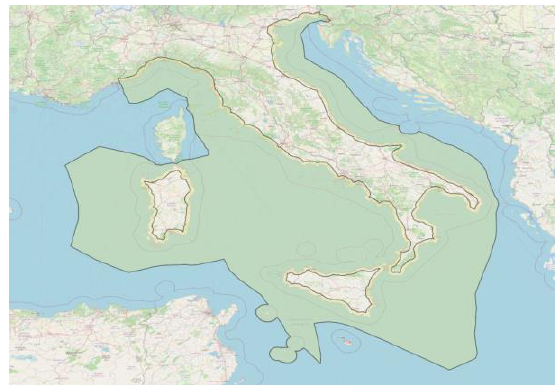
Figure 6. Italian maritime boundaries